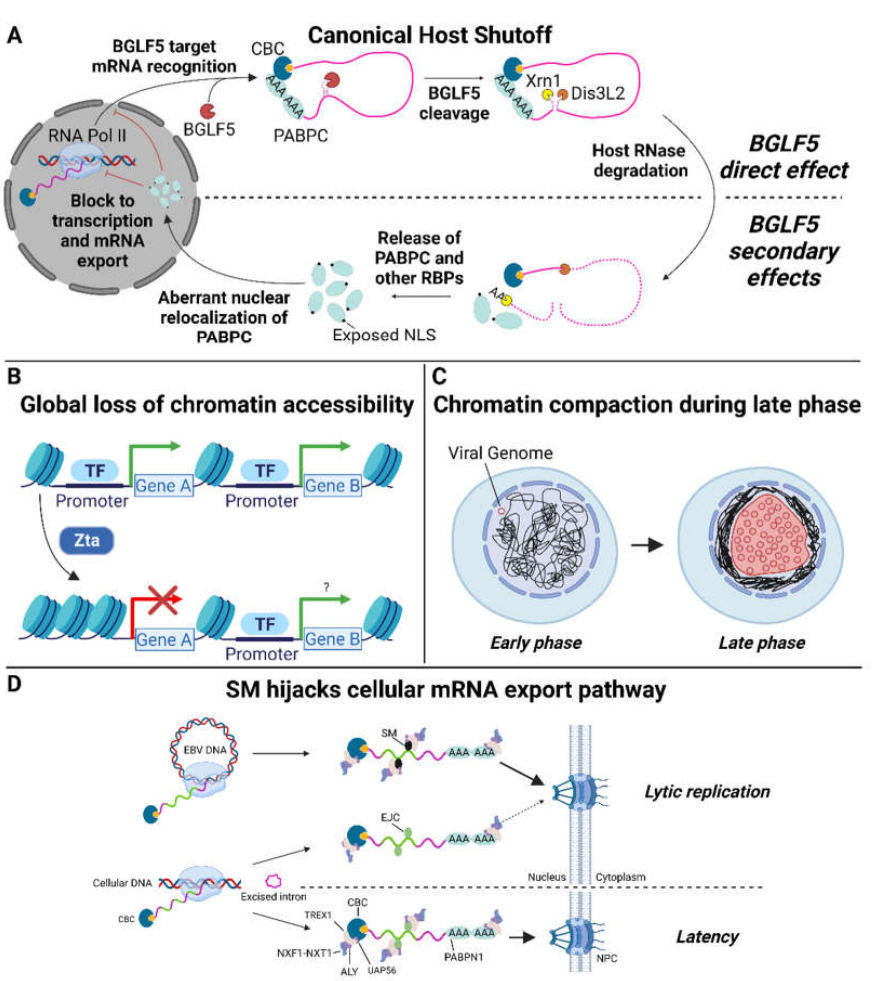
Figure 1. Canonical and non-canonical mechanisms of EBV-mediated host shutoff. ( A ) Canonical EBV host shutoff occurs in the cytoplasm via a two-step process: initial endonucleolytic cleavage by BGLF5 and subsequent degradation by cellular exonucleases (Xrn1, Dis3L2, and likely the exosome complex (not shown)). mRNA degradation releases RNA binding proteins (RBPs), which are recycled into the nucleus. The accumulation of RBPs, in particular the cytoplasmic poly(A)-binding protein (PABPC), induces a state of cellular stress that inhibits host gene expression by inhibiting transcription by RNA polymerase II and possibly by suppressing the nuclear export of mRNAs. ( B – D ) Non-canonical EBV host shutoff mechanisms include: ( B ) global loss of host chromatin accessibility induced by the immediate early protein Zta. ( C ) During the late phase of replication, host chromatin compaction occurs in parallel with the expansion of viral replication compartments that is believed to further disrupt the ability of the host cell to express its gene repertoire. ( D ) Preferential export of non-spliced viral mRNA mediated by the EBV SM protein. Abbreviations: NLS, nuclear localization signals; CBC, cap-binding complex; TF, transcription factor. Figure created with